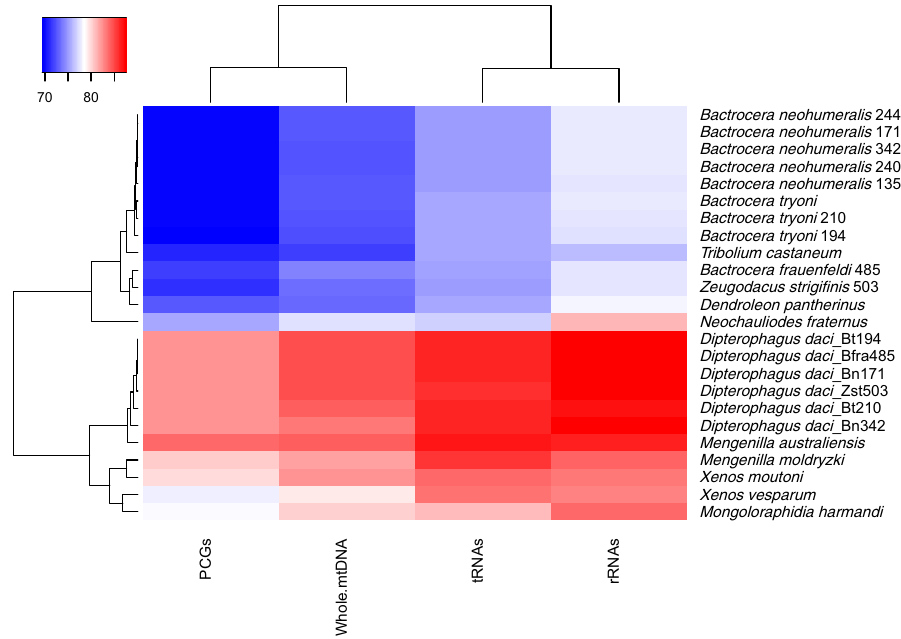
Figure 2. Comparative analysis of AT content of mitogenomes of Dipterophagus daci , its host fruit fly species and other reference